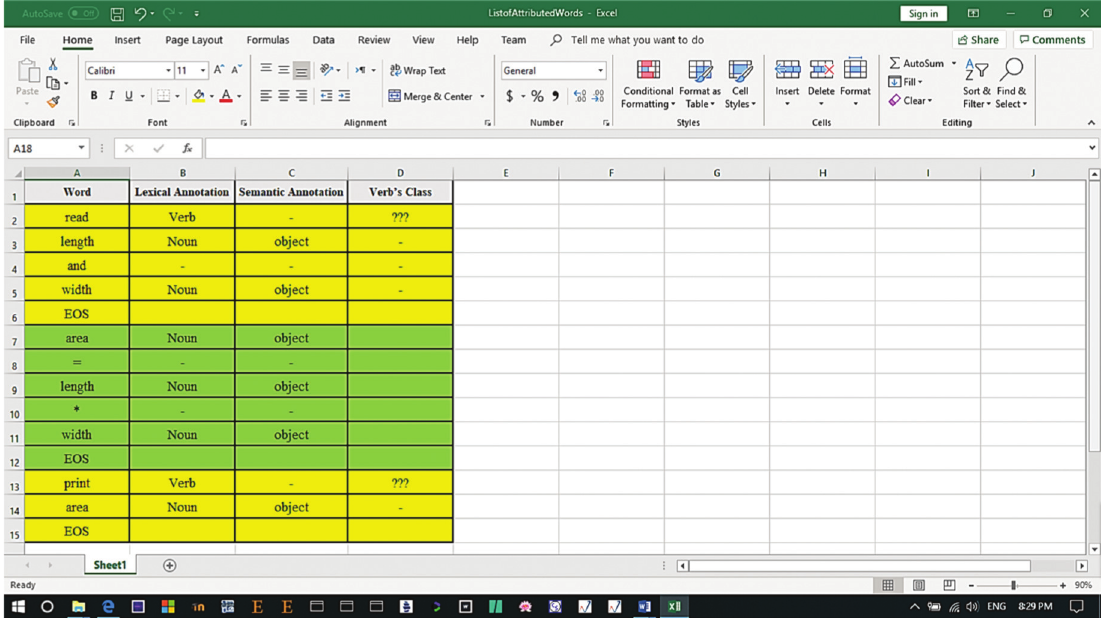
Figure 7: Excel File Showing the Structure of the Linguistic Matrix.